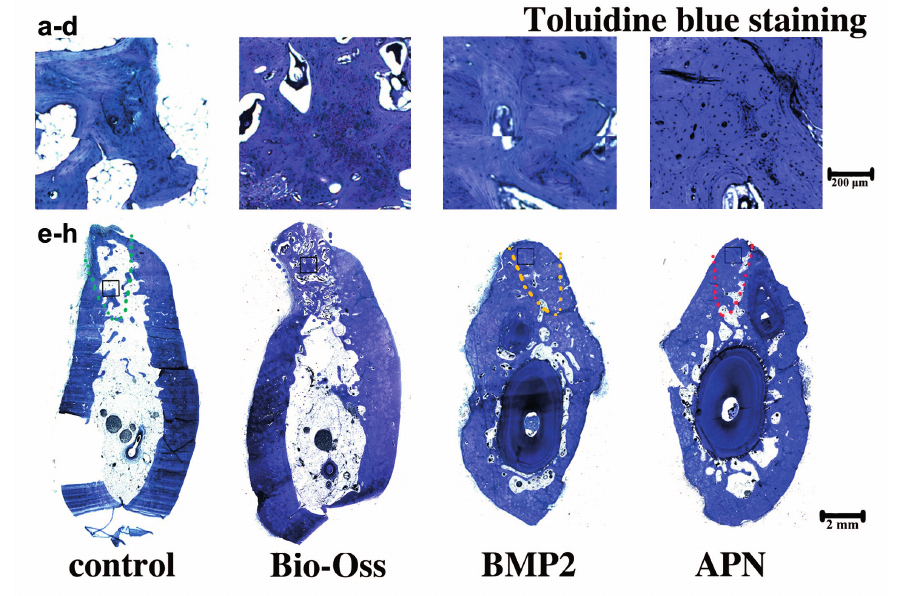
Figure 4. Decalcified toluidine blue staining of extraction sockets following the different 12-week treatments: ( a )The magnifying control group; ( b ) Bio-Oss group; ( c ) BMP2 group; ( d ) APN group; ( e – h ) represent the integral extraction socket of control group ( e ); Bio-Oss group ( f ); BMP2 group ( g ); APN group ( h ). The black square represents the magnifying area. The dashed line represents the extraction sockets. Magnification: upper panel 40×; lower panel 4×. n = 4 for each